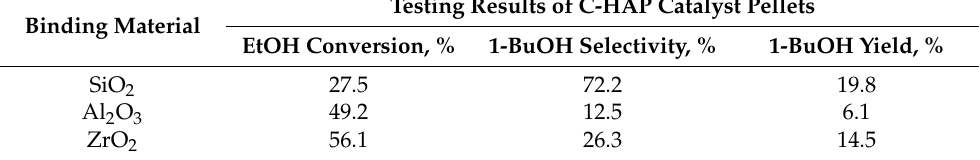
Table 3. Comparative testing of C-HAP catalyst pellets prepared by co-extrusion with